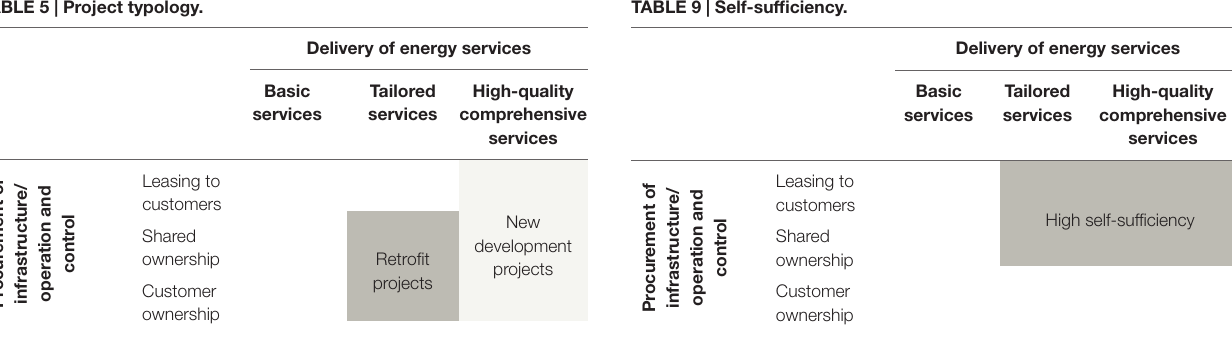
TaBle 5 | Project typology.